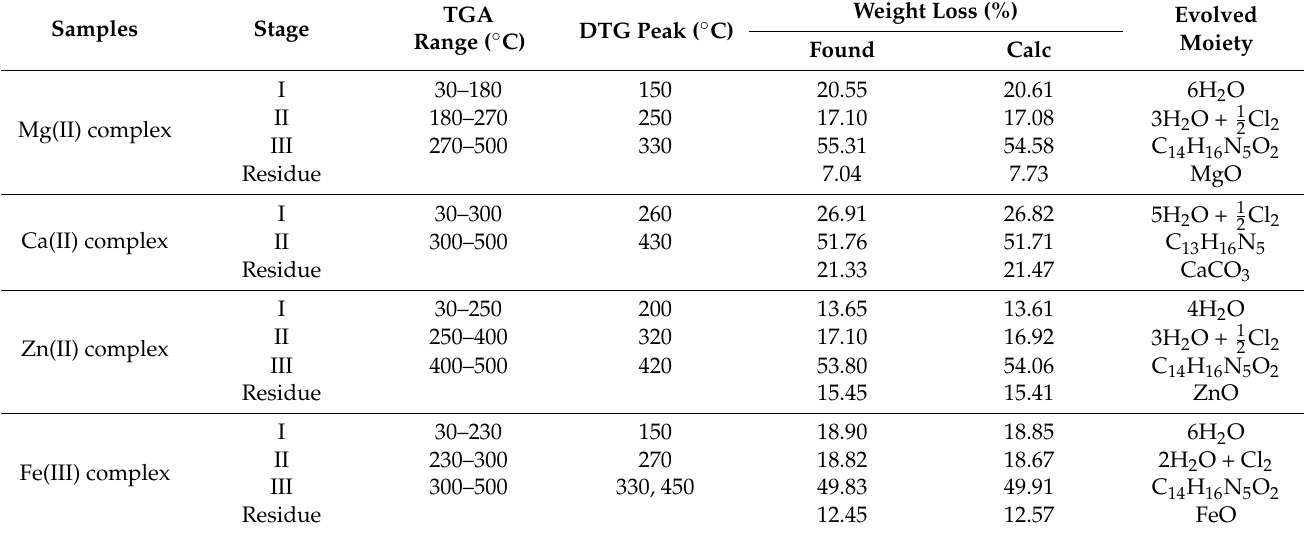
Table 4. TGA data for the Mg(II), Ca(II), Zn(II), and Fe(III)–pip complexes.